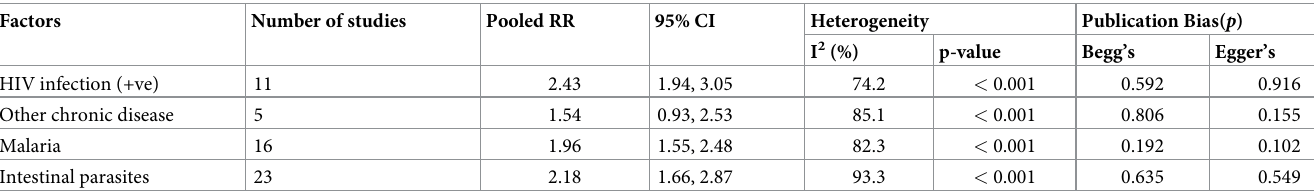
Table 5. Association of the different medical condition with anemia during pregnancy.